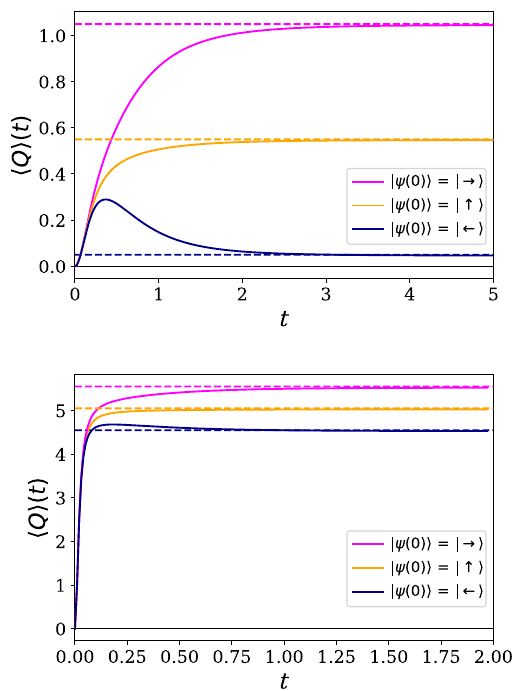
FIG. 3. Heat transfer for the spin-boson model in the high- temperature weak-coupling regime, with bath cutoff ω C = 5 (top) and ω C = 50 (bottom). Solid lines represent numerical results for the mean heat (cid:3) Q (cid:4) ( t ) transferred to the bath as a func- tion of time for three different initial states of the system. Dashed lines represent the asymptotic approximation for (cid:3) Q (cid:4) ∞ given by Eq. (49). The environment parameters are set to T = 5 and α = 0.1. The parameters controlling the numerical accuracy are K (cid:6) = 5, (cid:6) = 0.01, and p = 100, and the derivative is taken at u = 0.01 for ω C = 5 and u = 0.001 for ω C =